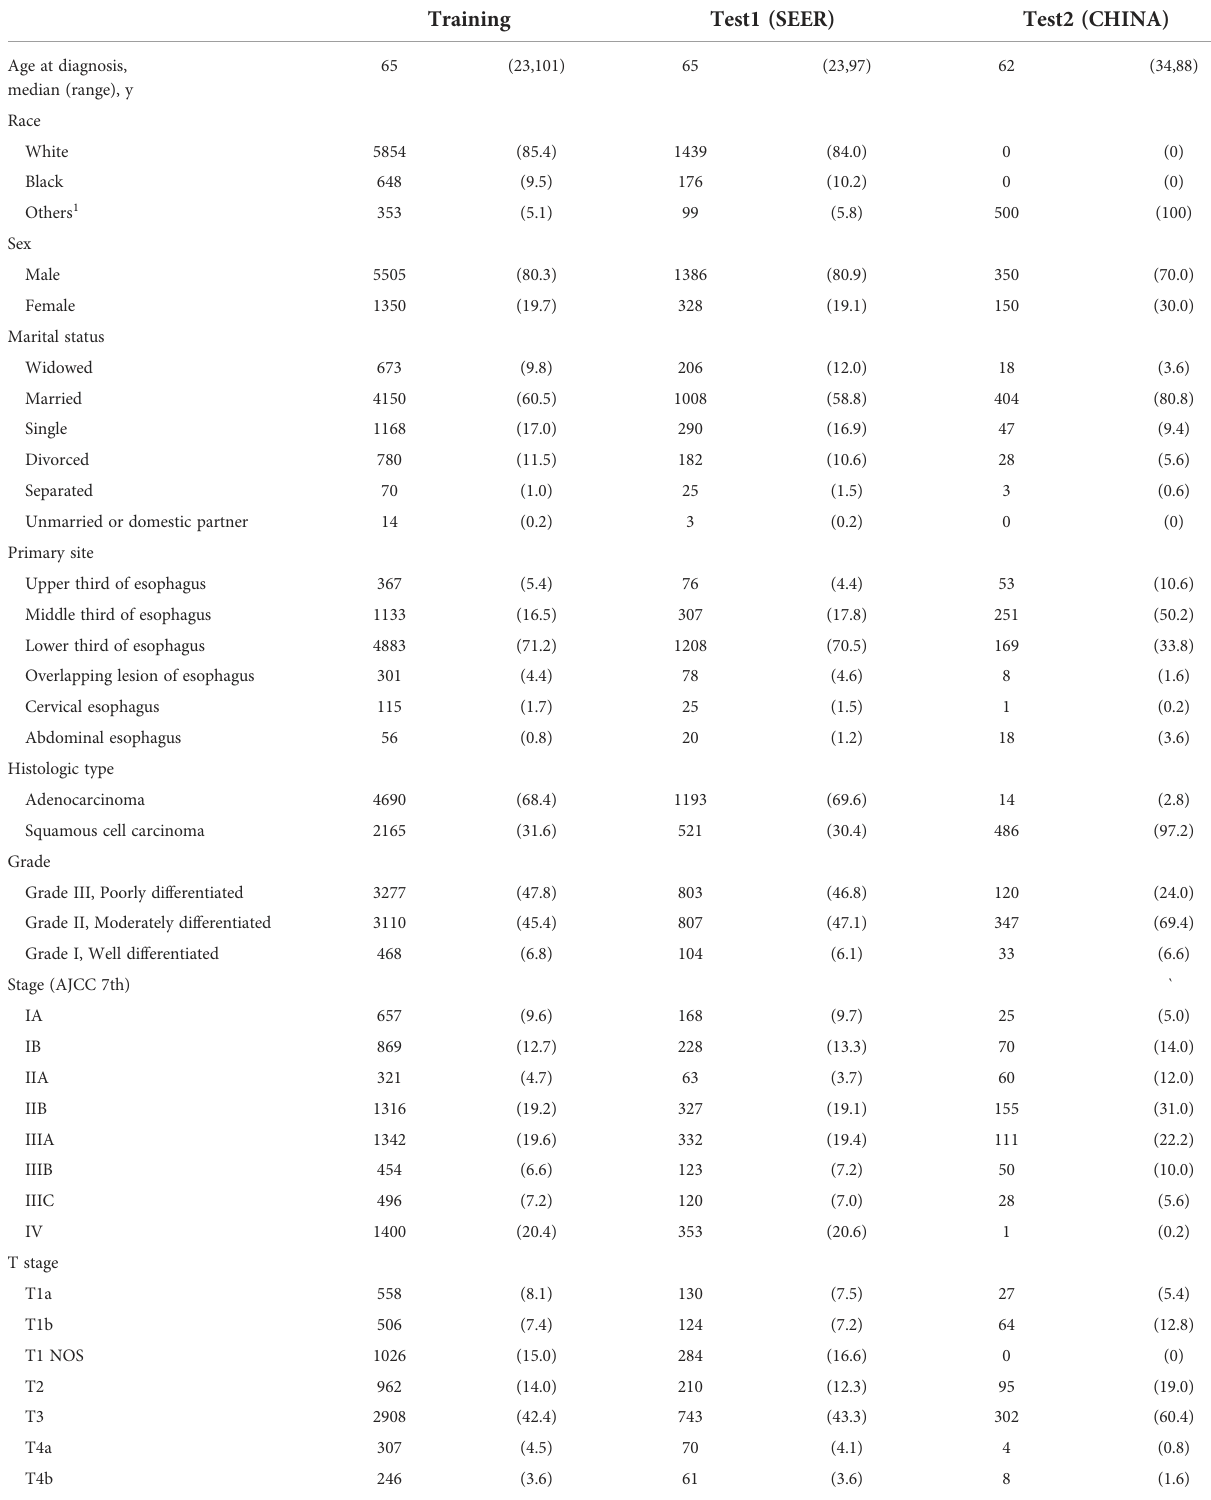
TABLE 1 Characteristics of patients in the whole data sets of survival analysis.